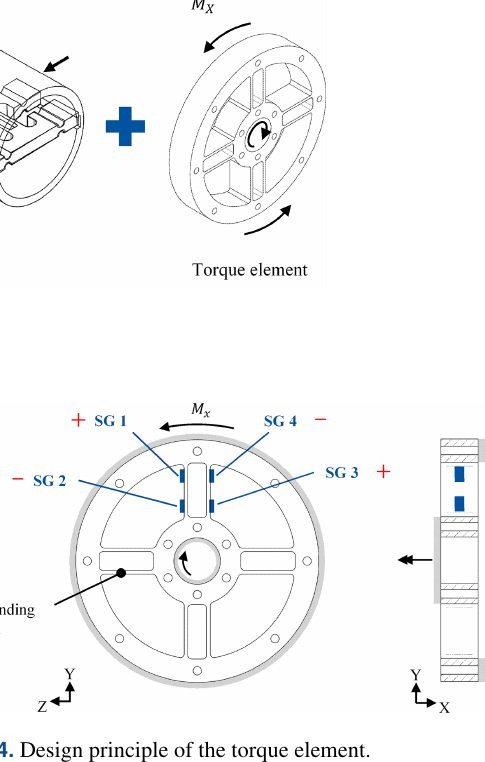
Figure 4. Design principle of the torque